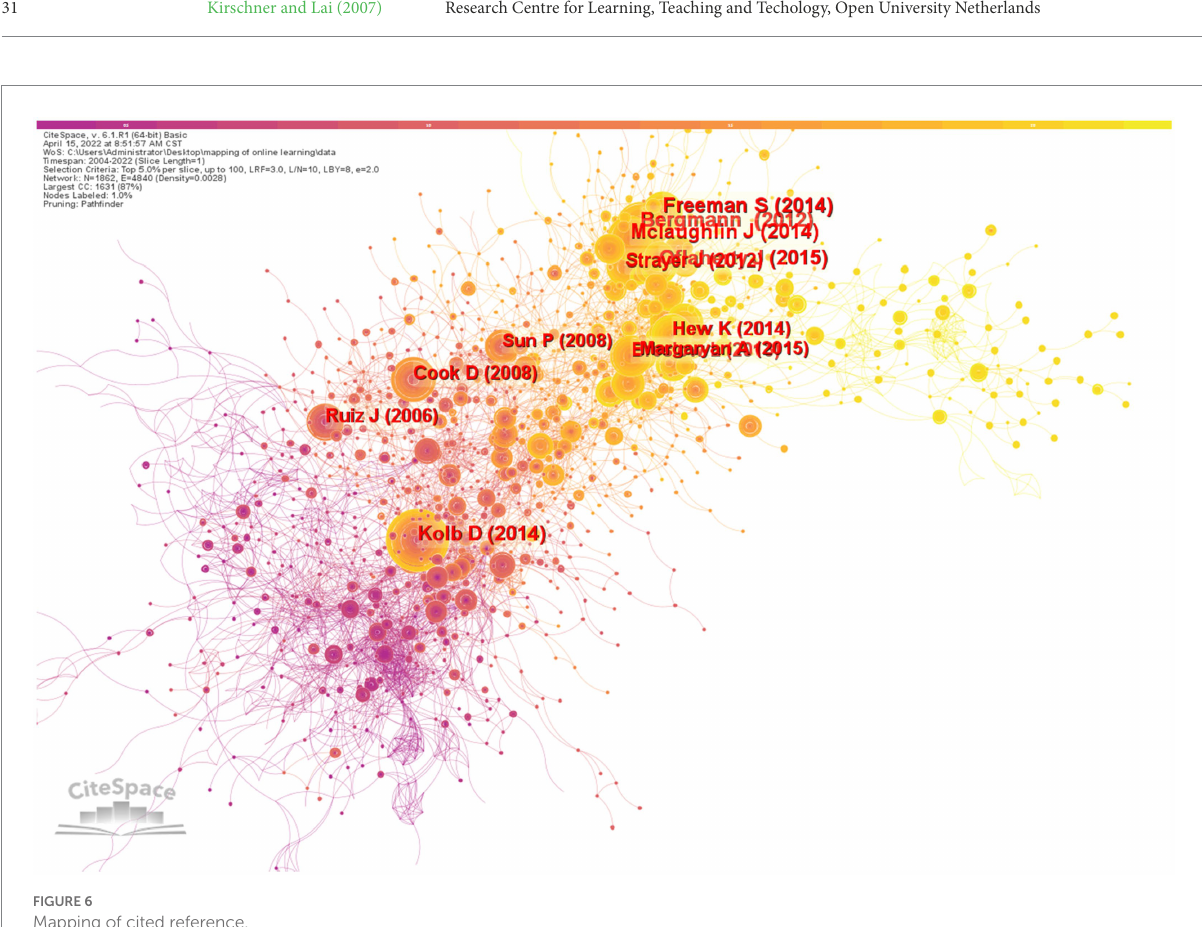
FIGURE 6 Mapping of cited